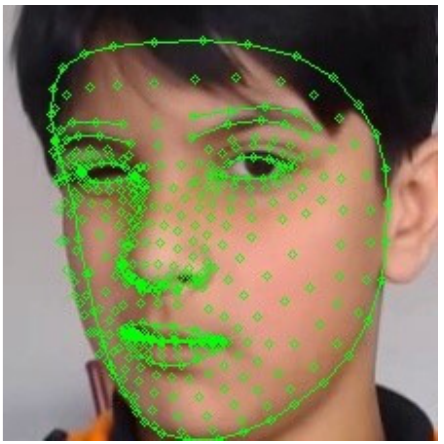
Figure 6. Face mesh/468 landmark points on disgust